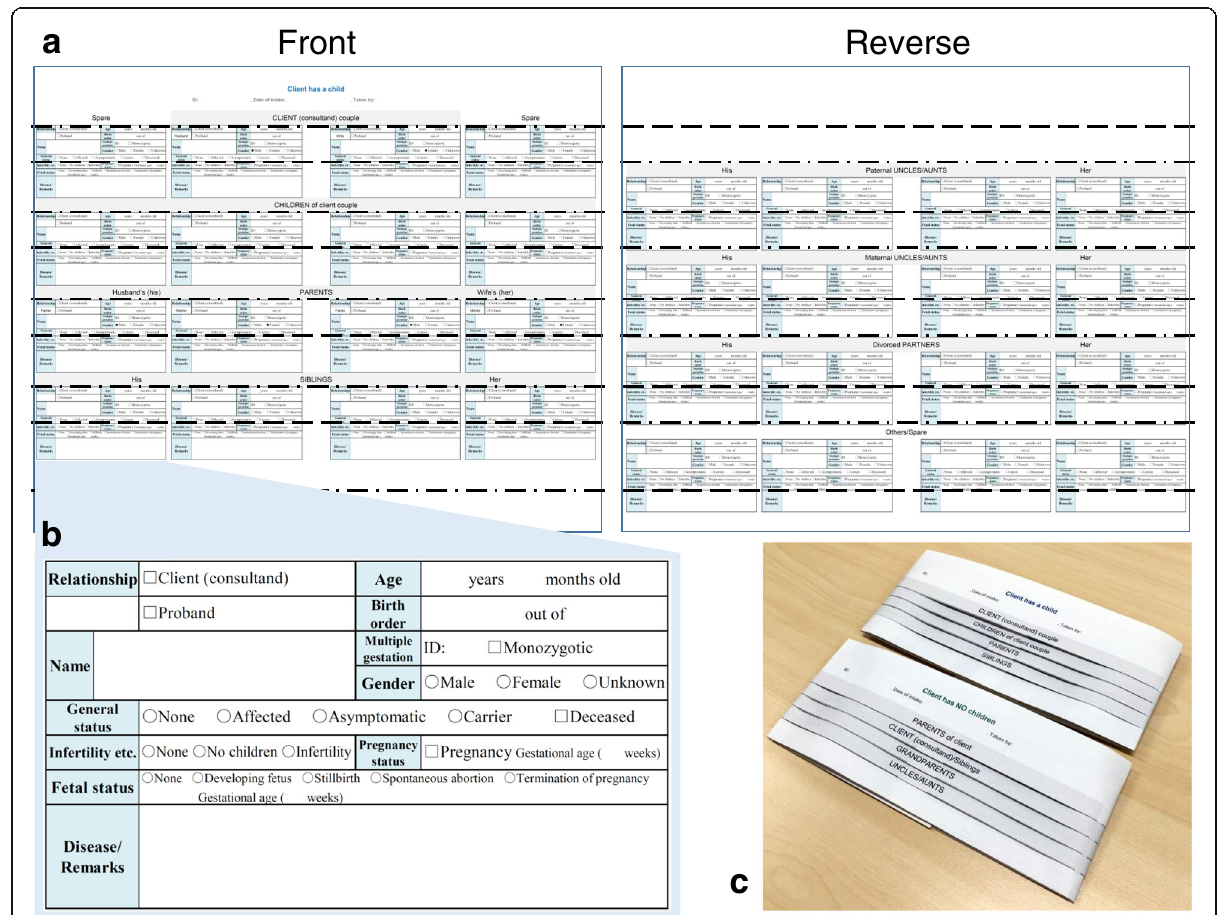
Fig. 3 Foldable interview sheet named “ f-sheet ” . a Large sheet, b gathered interview sheets for each individual, and c accordion-folded sheet. In diagram ( a ), the dashed-dotted lines, “ - ・ - ・ - ・ - ・ - ” , and broken lines, “ - - - - - ” , show the mountain fold and the valley fold,